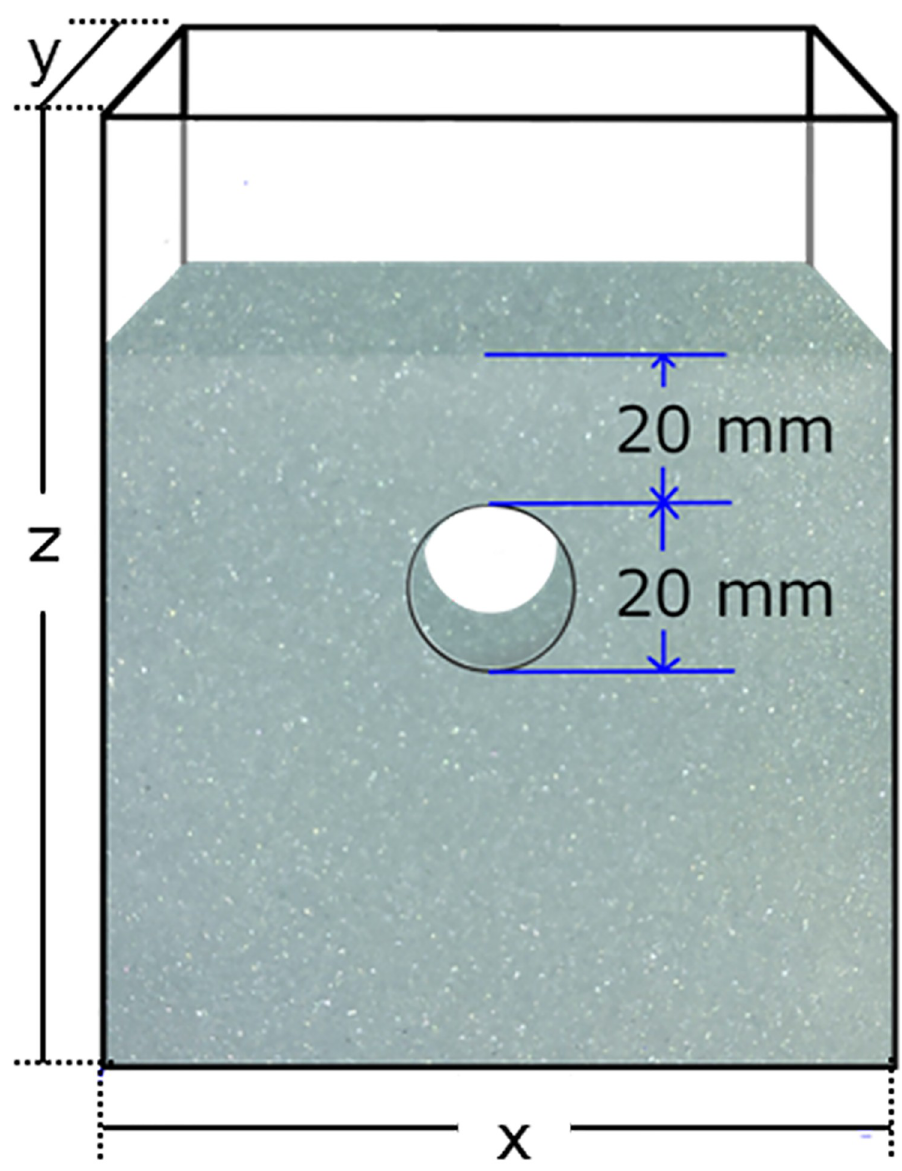
Fig 3. Schematic of an experimental container used to determine stability of a horizontal tunnel through wet granular substrate. This horizontal tunnel was 20 mm in diameter with a 20 mm of overlaying substrate. This container had the following dimensions: x = 100 mm, y = 50 mm, and z = 120 mm, but container sizes and tunnel diameters varied slightly to test different effects of sands on various tunnel